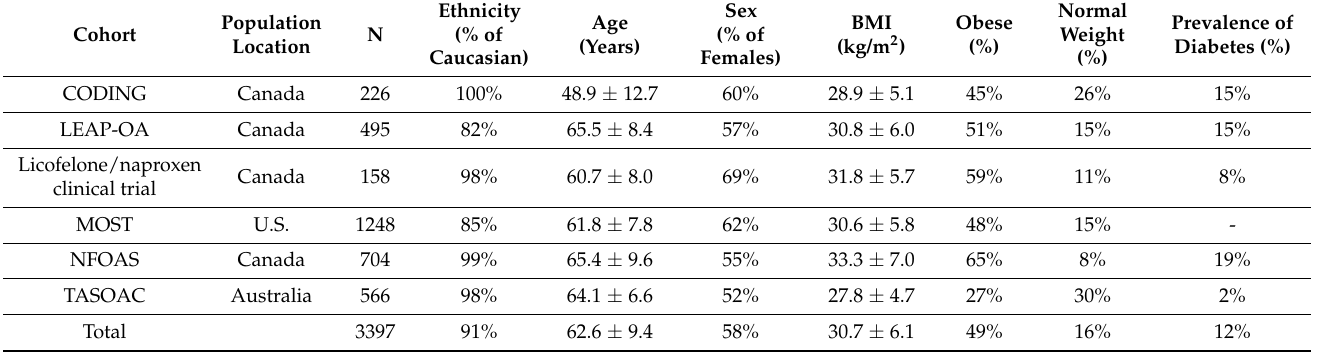
Table 1. Characteristics of study participants.